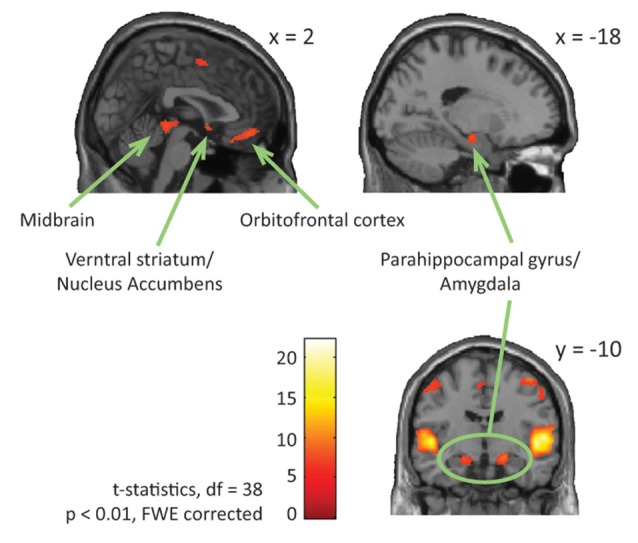
ASD and NT-main effect of emotional vs. neutral music. The figure shows brain activations in response to emotional compared to neutral music across all participants, including activations in midbrain, parahippocampal gyrus extending into amygdala, ventral striatum/nucleus accumbens, and orbitofrontal cortex. This figure is a reproduction of Figure 4 from Gebauer et al. (2014).